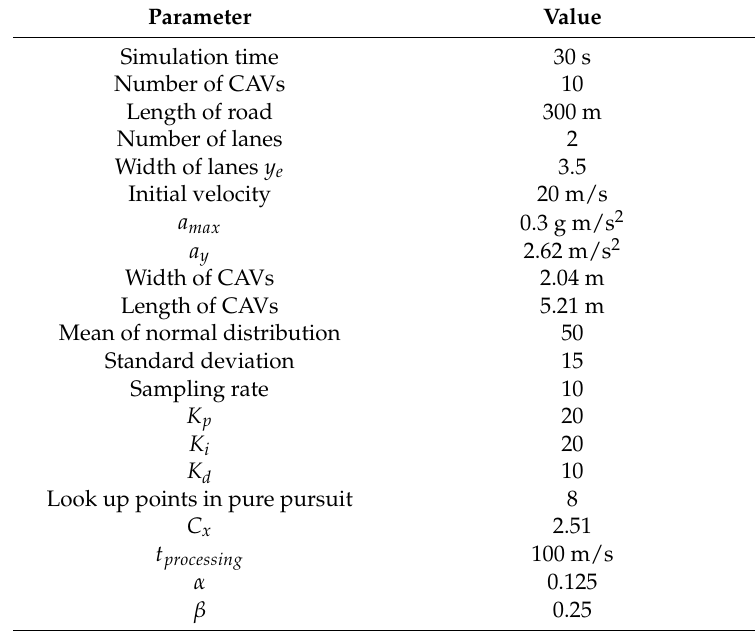
Figure 5. Screenshot of the road scenario. Table 1. Parameters in the lane change simulation.